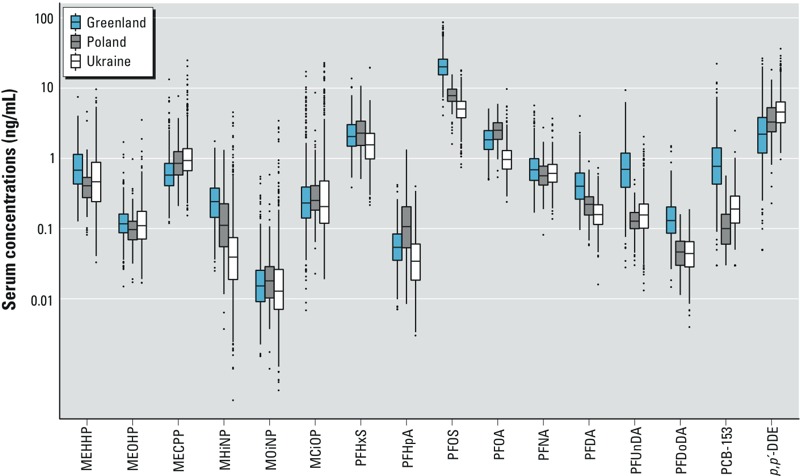
Box plots of distributions of exposure biomarker concentrations per study population. Horizontal lines correspond to medians, and boxes to the 25th–75th percentiles; whiskers extend to data within the interquartile range times 1.5, and data beyond this are plotted as dots. Wet weight concentrations are presented for PCB-153 and p,p’-DDE.